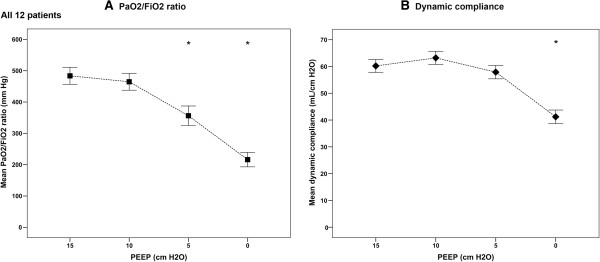
Changes in partial arterial oxygen pressure (PaO2)/inspired oxygen fraction (FiO2) ratio and dynamic compliance during a decremental positive end-expiratory pressure (PEEP) trial. (A) The PaO2/FiO2 ratio (mmHg) and (B) dynamic compliance (mL/cm H2O) are shown for the entire group. The PaO2/FiO2 ratio decreased with every PEEP step. The PaO2/FiO2 ratio showed a significant decrease at 5 and 0 cm H2O PEEP compared with 15 cm H2O PEEP. Dynamic compliance increased after reducing PEEP from 15 to 10 cm H2O. Thereafter, dynamic compliance decreased with each PEEP step. At 0 cm H2O PEEP dynamic compliance was significantly reduced compared with 15 cm H2O PEEP. Solid squares = PaO2/FiO2 ratio; solid diamonds = dynamic compliance. *P <0.05.